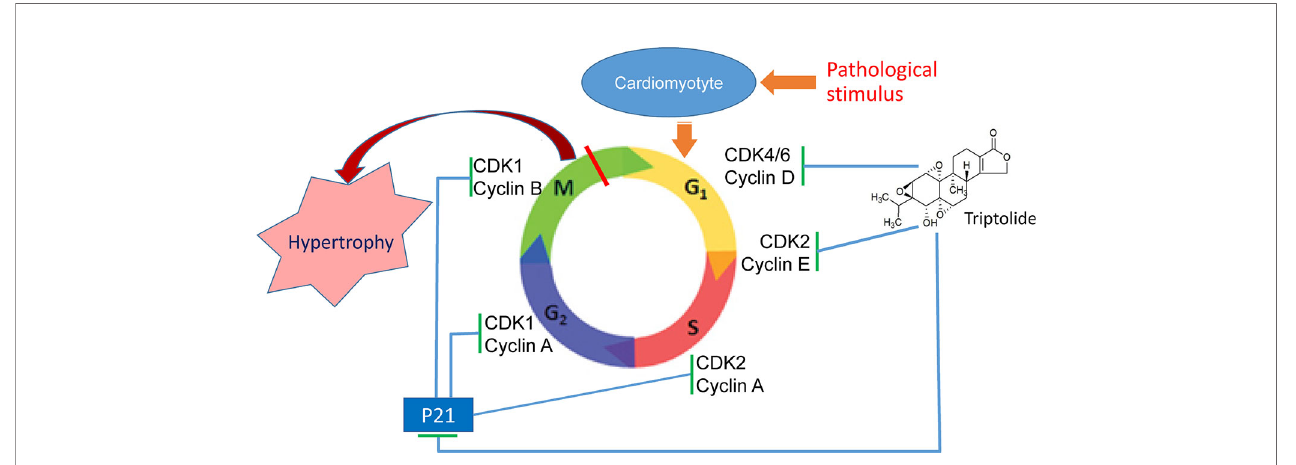
FIGURE 7 | Triptolide (TP) ameliorates cardiac hypertrophy via correcting the abnormal expression of cell cycle regulators in